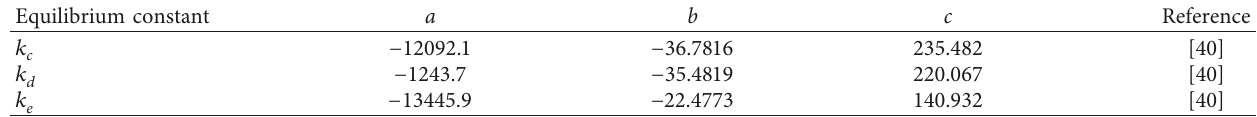
Table 3: Values of constants for equation (25).